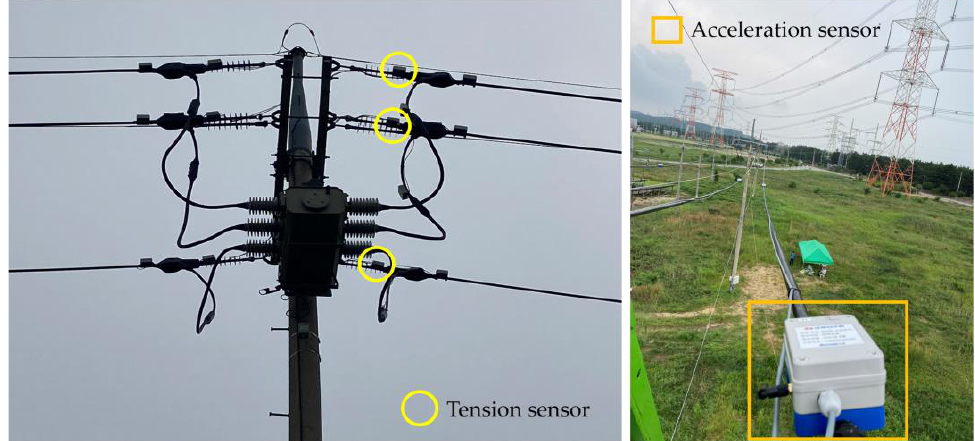
Figure 4. Sensor attachment example in the Gochang Electric Power Testing Center.